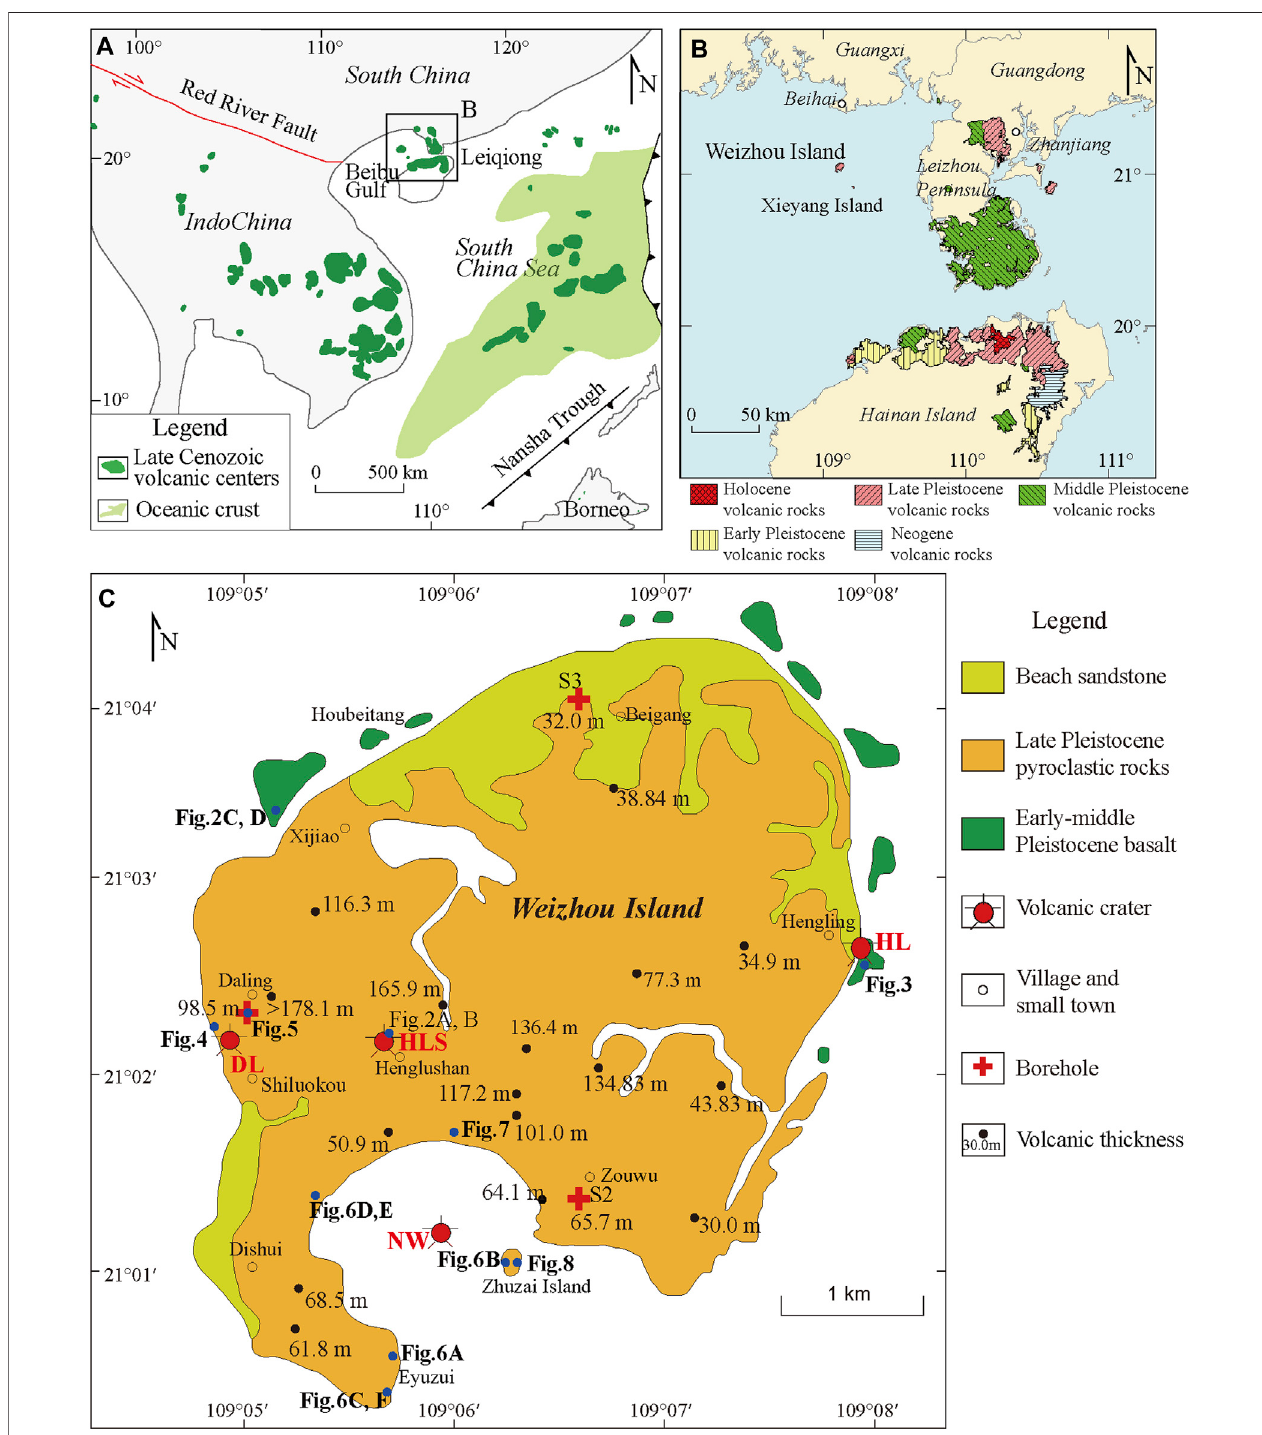
FIGURE 1 | (A) Distribution of Late Cenozoic basalts in the SCS and its periphery (Yan et al., 2018). (B) Quaternary volcanic rocks distribution of Leiqiong and the surrounding area of Beibu Gulf, southern China (modi fi ed from) (C) Geological map of volcanoes on Weizhou island (modi fi ed from Fan et al., 2006; parts of the drilling depths are from Lu, 1993). HLS-Henglushan volcano, HL-Hengling volcano, DL-Daling volcano, NW-Nanwan volcano.